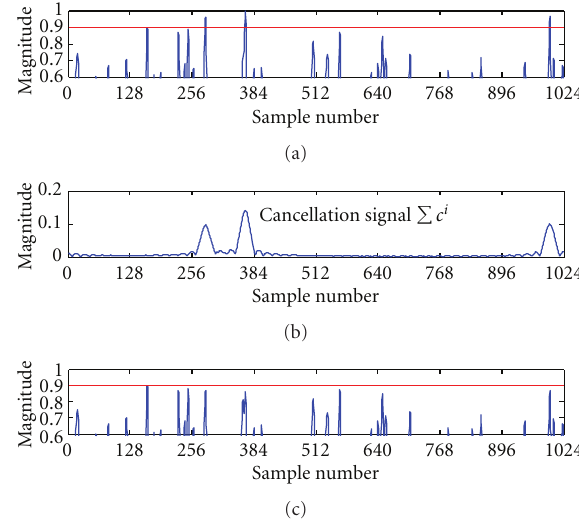
Figure 3: Parallel cancellation process: (a) the original OFDM signal; (b) the composite cancellation signal; (c) the OFDM signal after PAPR